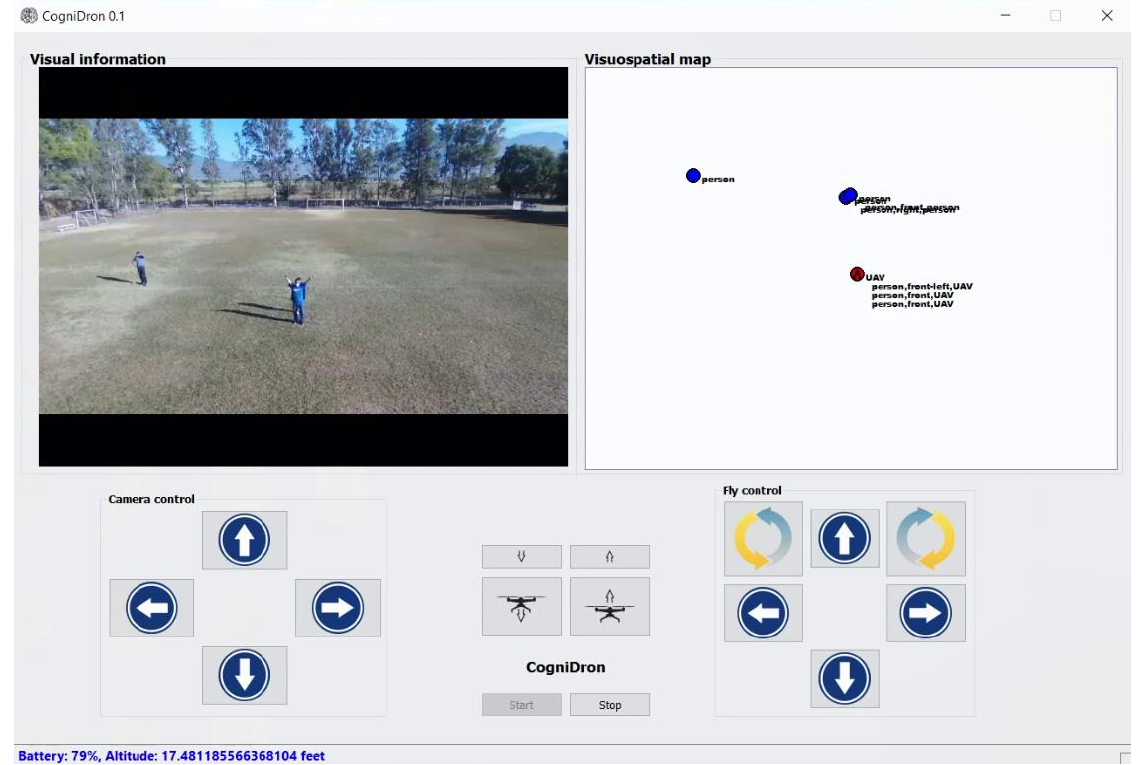
Figure 7. Generating visuospatial maps when a total occlusion happens.